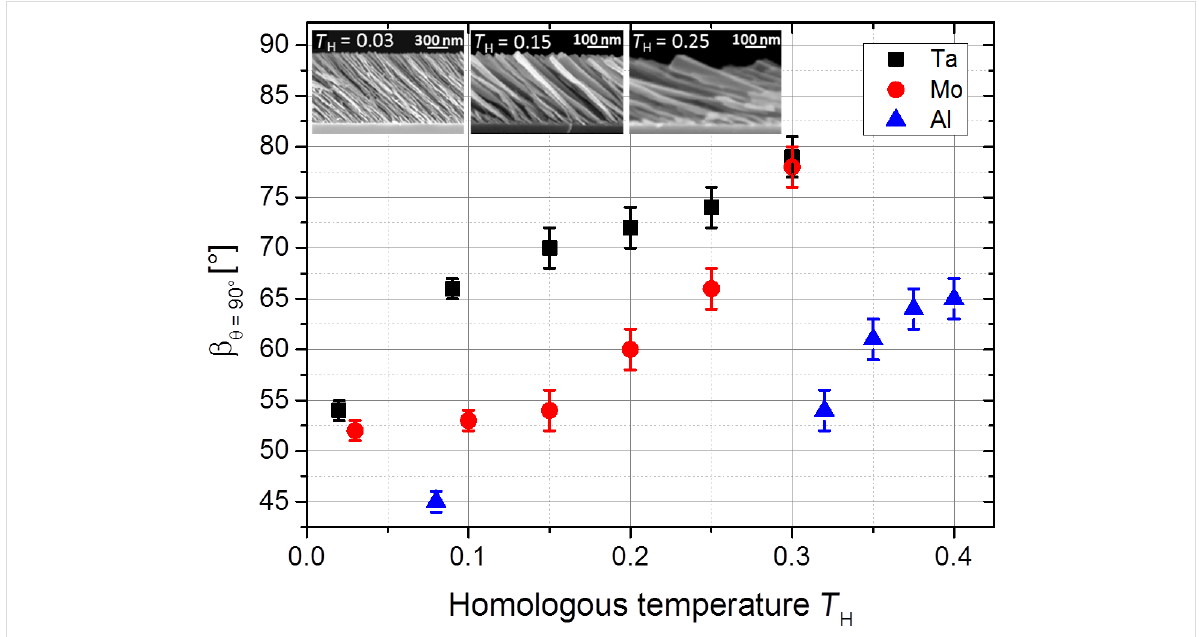
Figure 6: β θ =90° -values for Ta, Mo and Al columns depending on the homologous temperature (for explanation see text). Inset: Cross-sectional SEM images of tilted Mo columns grown at an incidence angle of 82° on thermally oxidized Si substrates at T H = 0.03 (left), T H = 0.15 (middle) and T H = 0.25